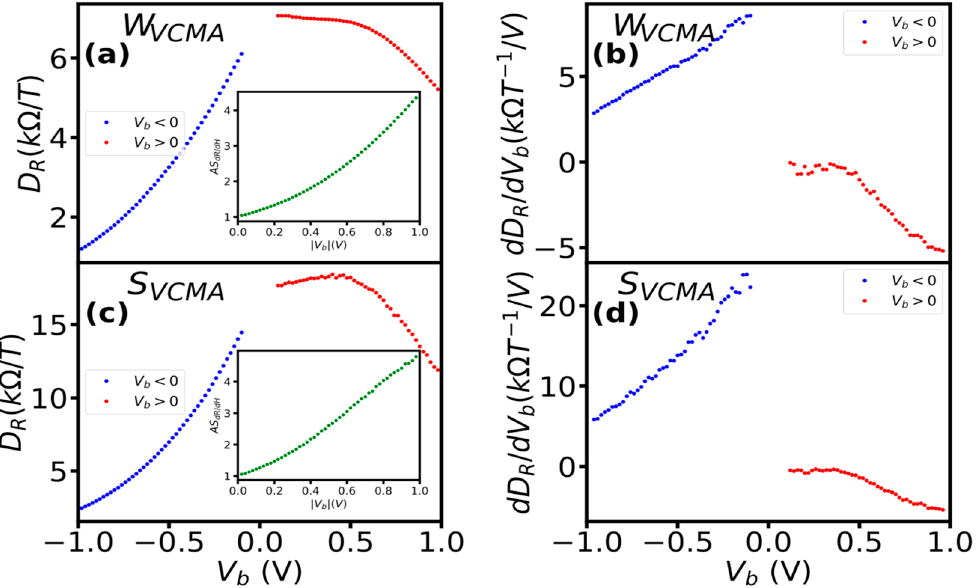
Figure 6. The influence of bias polarity on D R = dR/d μ 0 H and their symmetry (inset) ( a , c ) and the rate of D R ( b , d ) of sensors with weak and strong VCMA. The asymmetry was computed as AS dR/dH = dR/d μ 0 H(+V b )/dR/d μ 0 H( − V b ).